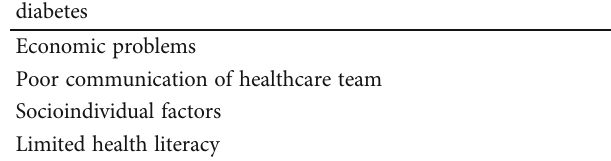
Table 1: The main results of this